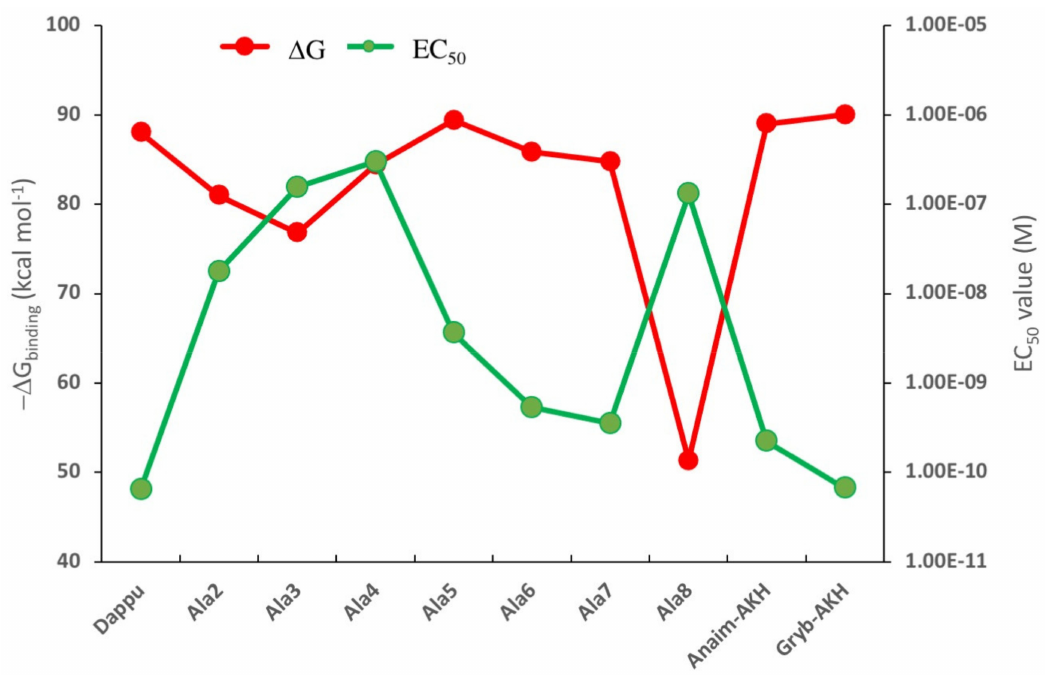
Figure 1. ∆ G binding calculated for a series of mutated Dappu-RPCH ligands bound to Dappu-RPCH R, and the EC 50 values for the same ligands tested on Dappu-RPCH R-expressing cells in an in vitro bioluminescent assay [13]. Only those mutated ligands are shown for which EC 50 values did exist. Results for [Ace]Dappu-RPCH and [COOH]Dappu-RPCH are not included as they were not residue-scanning, mutation options of the Schrödinger software.